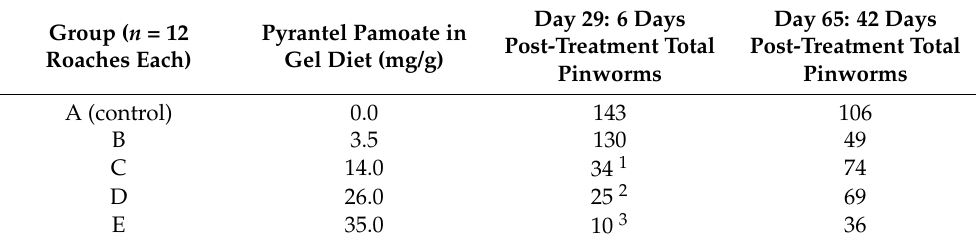
Table 3. Dubia roach, Blaptica dubia , hindgut examination results of pinworm ( Leidynema appendiculata ) counts (#) at Day 29 (6 days after oral pyrantel pamoate anthelmintic medicated gel diet treatments ended) and Day 65 (42 days after treatment